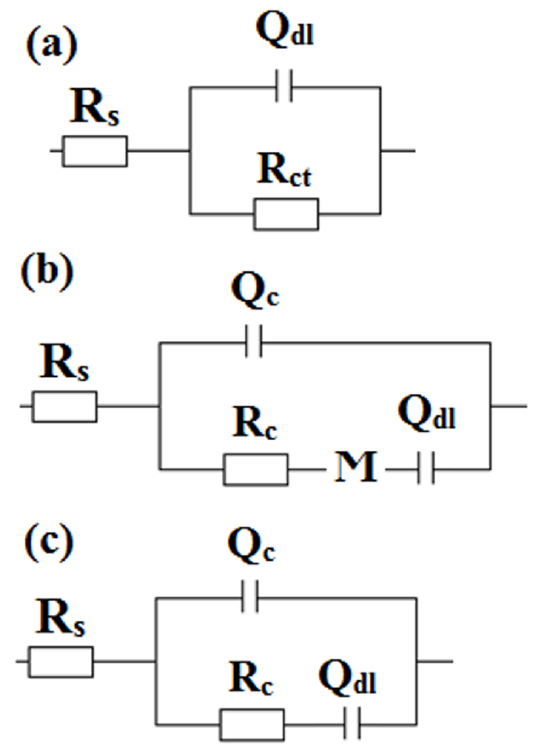
Figure 8. Electric equivalent circuits (EEC) fitted to EIS data of ( a ) bare 304 stainless steel, ( b ) samples R1, R3, R4, R5 and ( c )